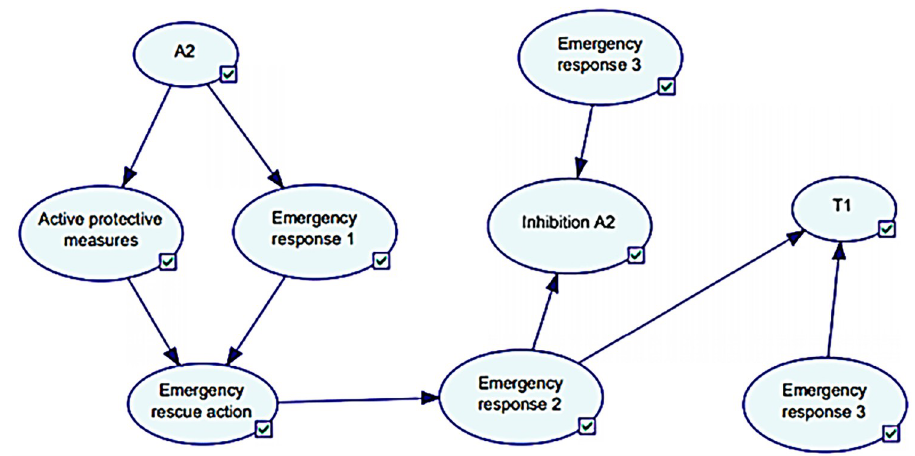
Fig 10. The emergency rescue process fitted by the Bayesian network diagram.